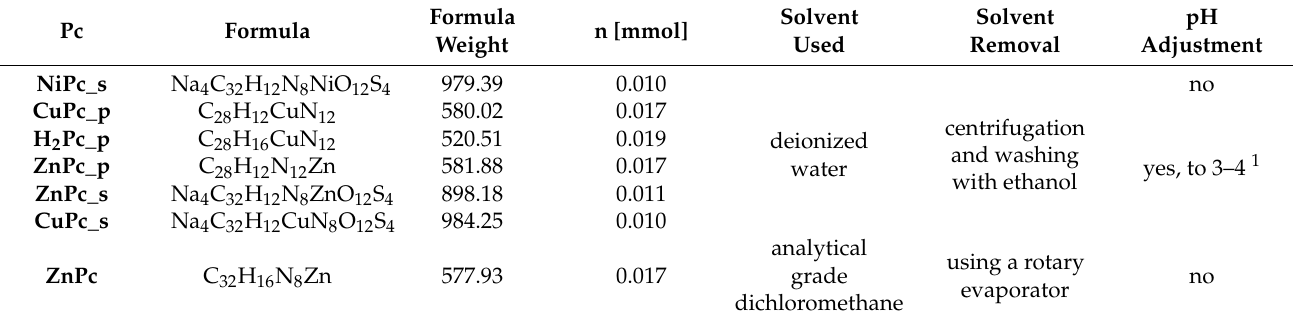
Figure 3. Schematic representation of the preparation of the photocatalytic materials by the chemical deposition method. Table 1. Modifications to the chemical deposition procedure, specified for each of the prepared materials. n—calculated number of moles of the Pc